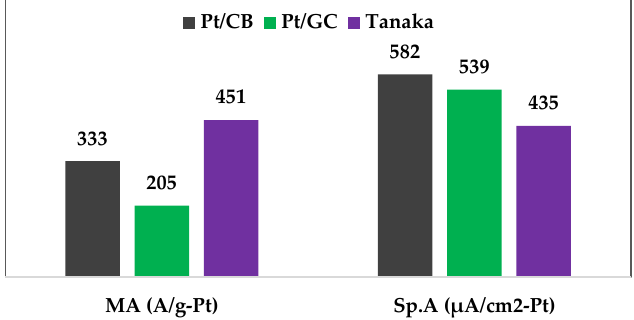
Figure 5. ORR activities of the supported catalysts at 0.9 V vs. RHE electrode in 0.1 M HClO 4 electrolyte at 50 mV/s scan rate at room temperature.